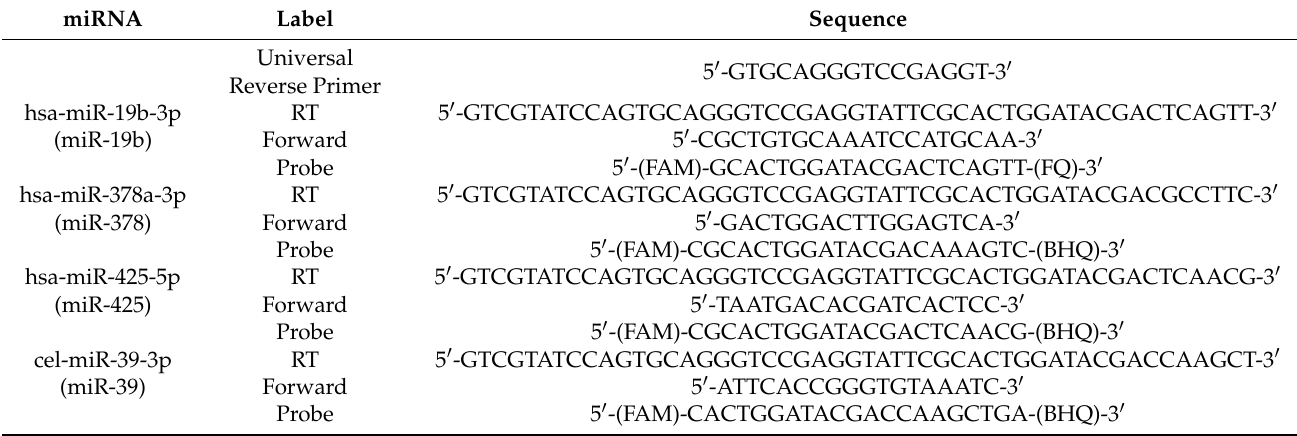
Table 1. Sequences of primers and probes used for reverse transcription and TaqMan qPCR.